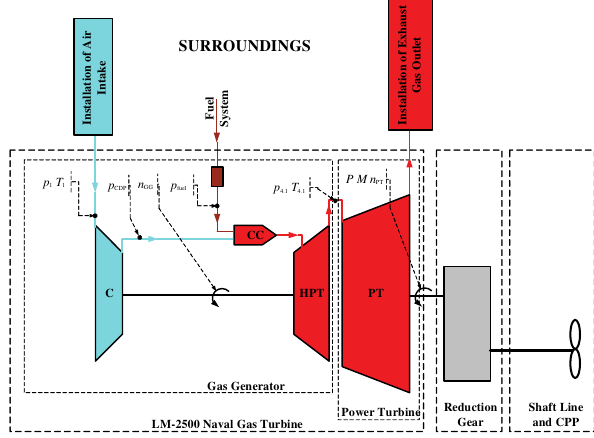
Fig. 2. The schematic diagram of LM-2500 naval gas turbine and the legend describing location of the measured parameters The parameters were measured simultaneously for both engines, on the load of both engines simultaneous and bal- anced. The measurements were made using the portable measuring-recording system, Multichannel Recorder type 908416161C and additionally, the operating parameter values were read and recorded from digital displays on the main control panel in the engine control room. The meas- urements were made for 60 seconds at specific load set- tings, with the sampling rate of 2 Hz, and then averaged. Measurements were preceded by the calibration of individ- Table 1. Parameters of LM-2500 naval gas turbine measured during the ual measuring circuits including the assessment of their study [18] uncertainties. The measuring-recording system during the parameter measurement is shown in Fig. 3. designation